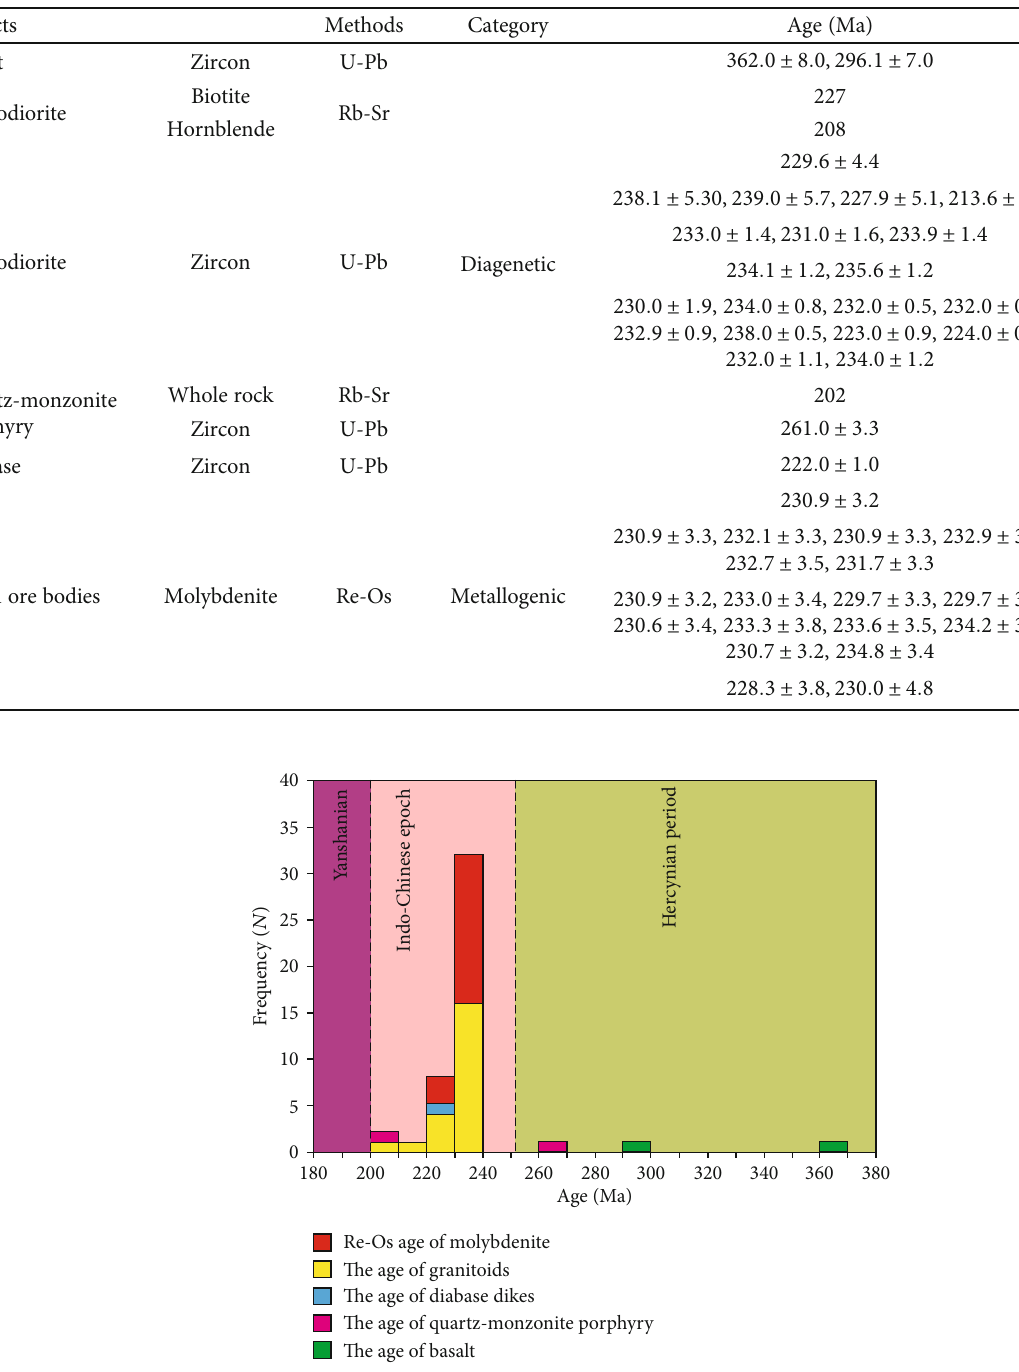
Figure 3: The histogram of diagenetic and metallogenic ages of the Yangla copper deposit, Yunnan, China (the data after References [1, 2, 8, 24, 25, 27 – 31, 34, 35,